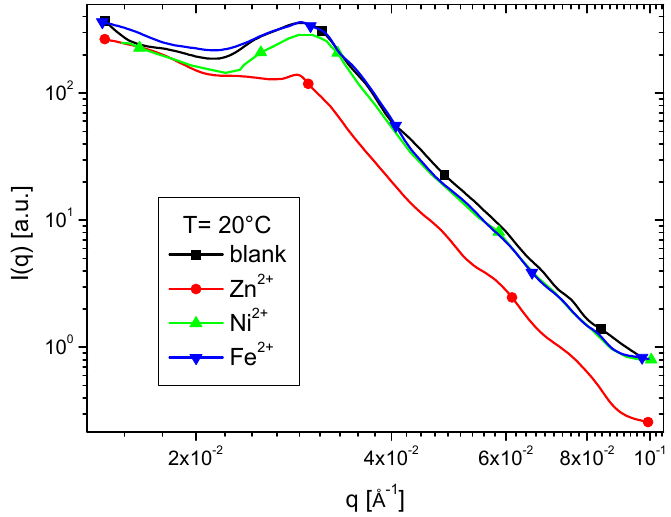
Figure 1. SAXS data collected on the investigated PS-b-PtBA micellar solutions in ethanol at a concentration of 12 w/v%.